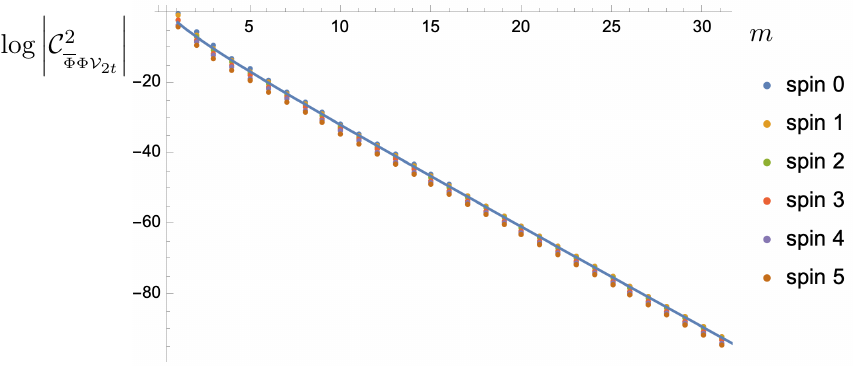
(cid:12) (cid:12) 2 against the level number m displaying (cid:12) (cid:12) C (cid:12) (cid:12) ΦΦ V 2t log m predicted in (4.38) (indicated 6